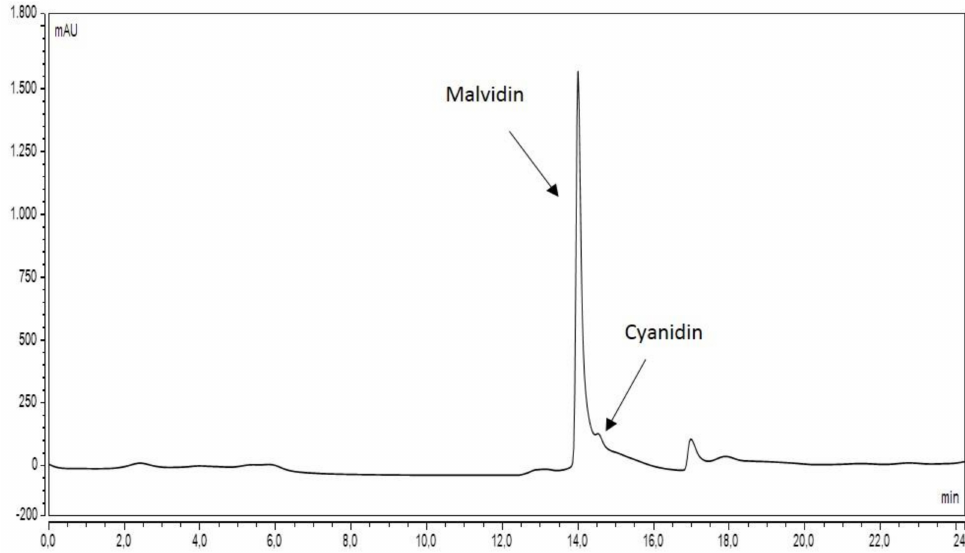
Figure 1. Chromatographic profile of açai extract by reverse-phase HPLC. We identify two main peaks that have the same retention times of chromatagram reported by Petruck et al. The two species can be malvidin and cyanidin, the active principles of açai extract.